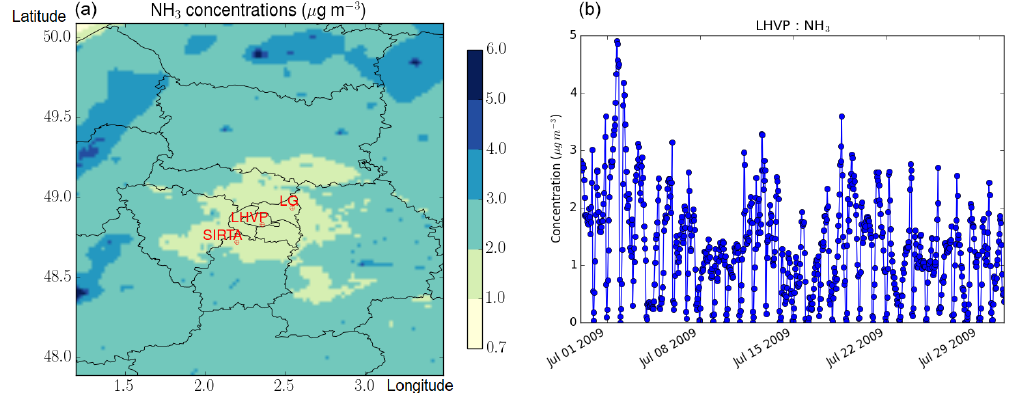
Figure 6. Monthly average NH 3 concentration (a) and hourly evolution of the NH 3 concentrations (in µgm − 3 ) at the LHVP site (b) . Table 2. Model-to-measurement comparisons of daily number concentrations of particles with a diameter higher than 10nm in July 2009 at LHVP, SIRTA, and GOLF. o and s stand for mean observation and simulated concentrations, respectively. Corr. stands for correlation. NMB and NME stand for normalised mean bias and normalised mean error,